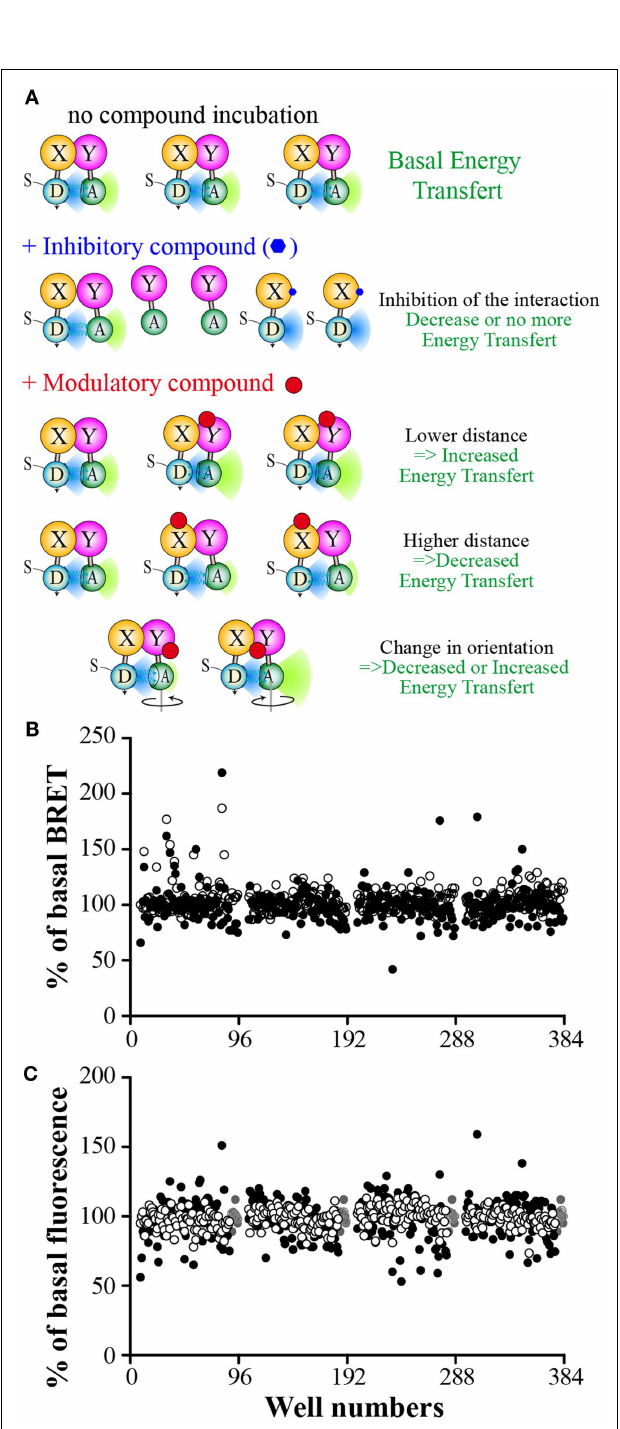
FIGURE 4 | Expected results from a P2I2 BRET-based screening assay. (A) Different expected BRET change upon inhibitor or modulator compound action compared to basal BRET signal. X and Y : Protein X and Y ; D: energy donor; A: energy Acceptor; S: BRET Substrate. (B) Results of a 320 • ◦ compounds miniscreen using OBRc/OBRGRP ( ) and CD4/PLSCR1 ( ) BRET-based screening assays, expressed as% of basal BRET in absence of compound in each plate. (C) Fluorescence measured from the same plates as in (B) expressed as % of fluorescence value in absence of compound • (represented by